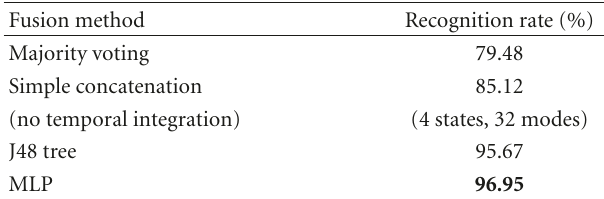
Table 4: Average recognition rates reached by the four fusion